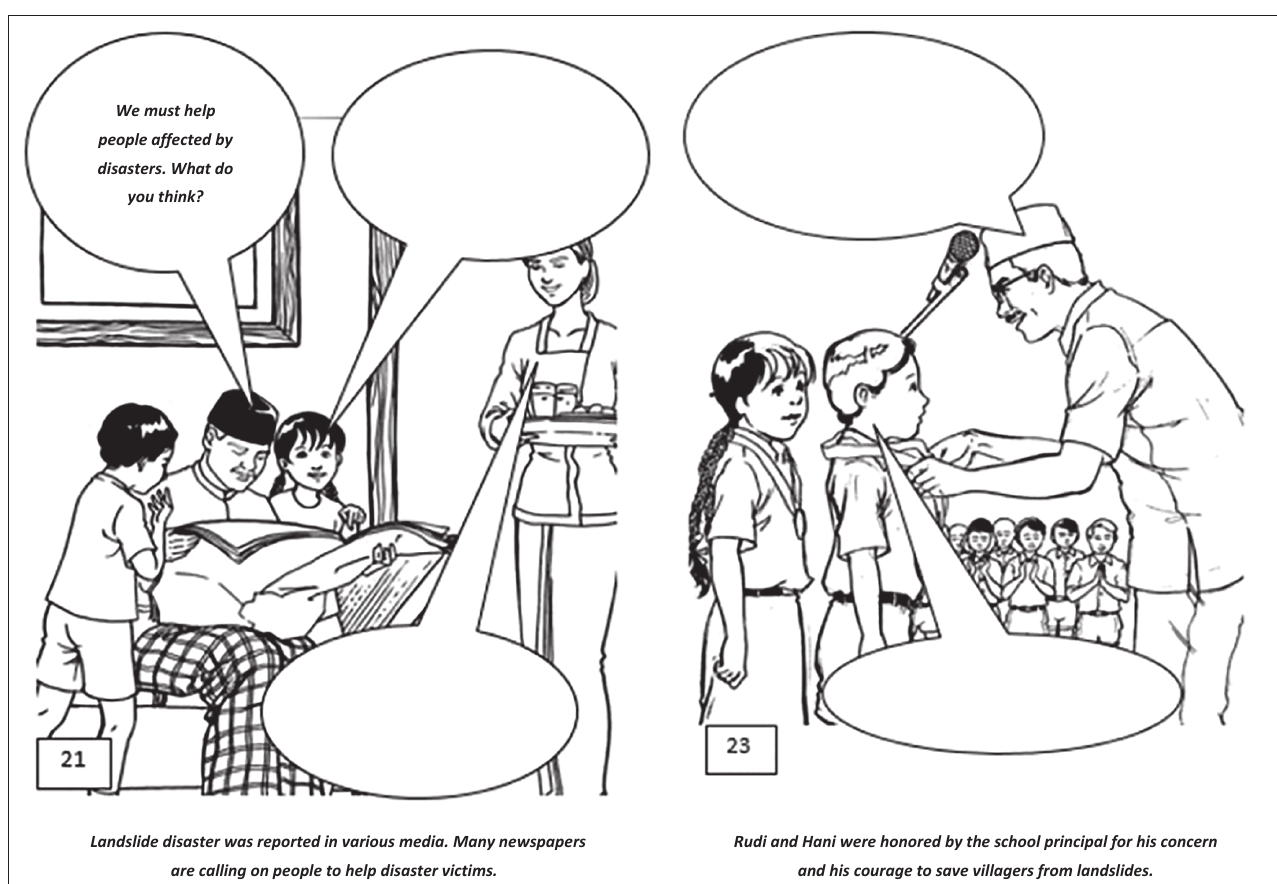
FIGURE 1 : Excerpts from the comic (scenes 21 and